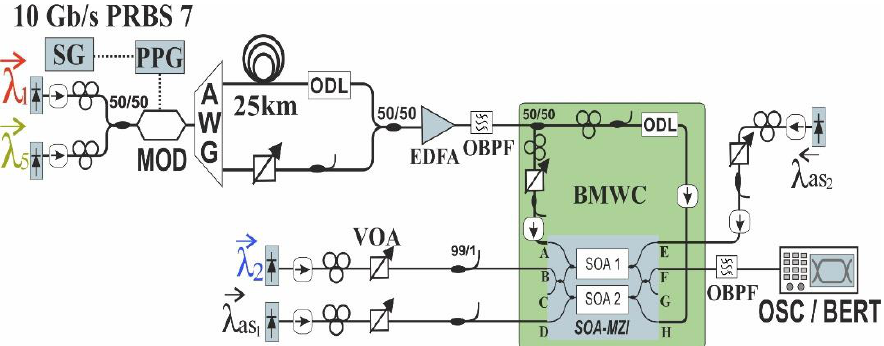
Figure 4. Experimental setup for testing the BMWC with 25 km fiber transmission. AWG: Arrayed Waveguide Grating.